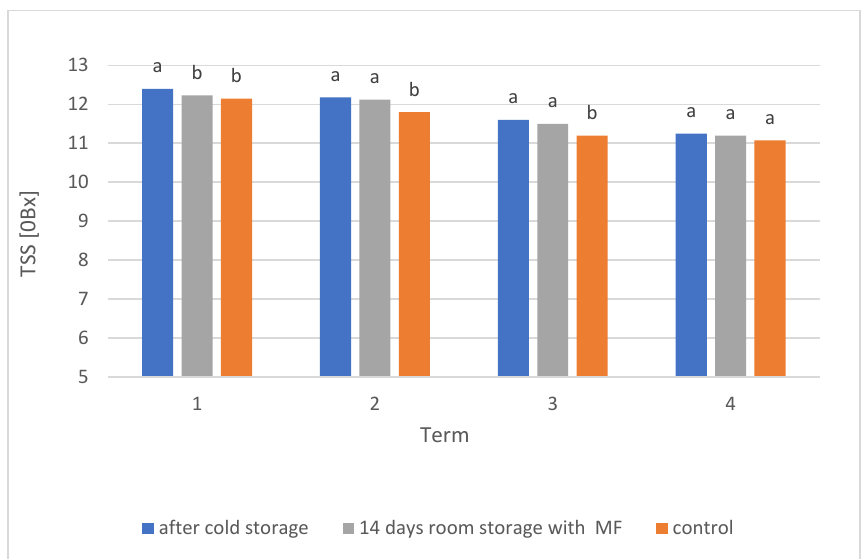
Figure 5. Effects of MF on the TSS of Idared apples after 120 days of cold storage. For each experiment, apples were stored in room conditions for 14 days. Statistically significant differences are marked by different letters. Differences between average values that are marked with the same letters (a – b) are not statistically significant. The data were analysed separately for each experiment .